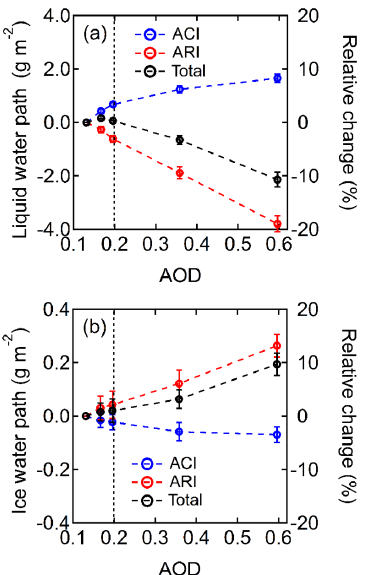
Figure 5. Changes in (a) cloud LWP and (b) cloud IWP with increasing BB emission intensity (indicated by domain-averaged AOD in each emission scenario). The vertical dotted line in each plot indicates the EMIS1 scenario. Error bars denote the standard